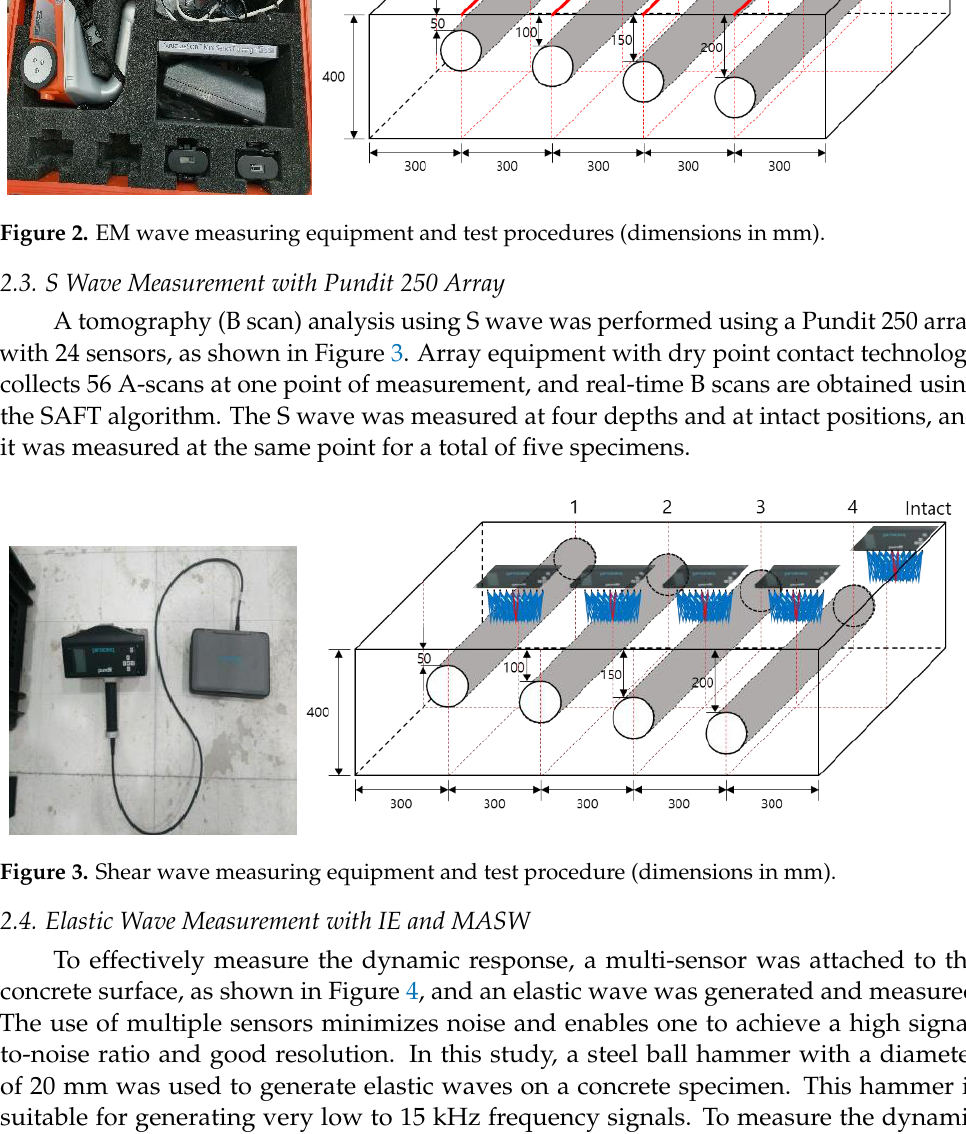
Figure 1. Cross-sectional dimensions (in mm) and manufacturing results of the tested concrete specimens.